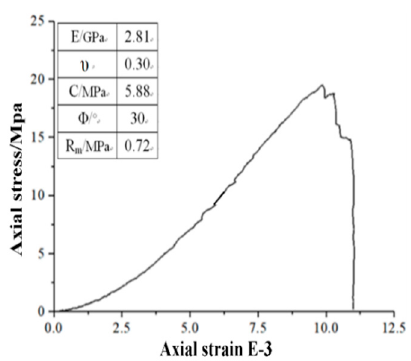
Figure 5. Failure pattern of coal samples.